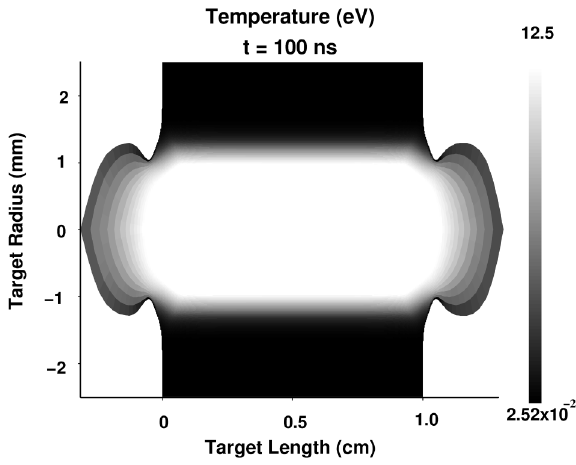
FIG. 12. Temperature at t (cid:3) 200 ns corresponding to the case shown in Fig.